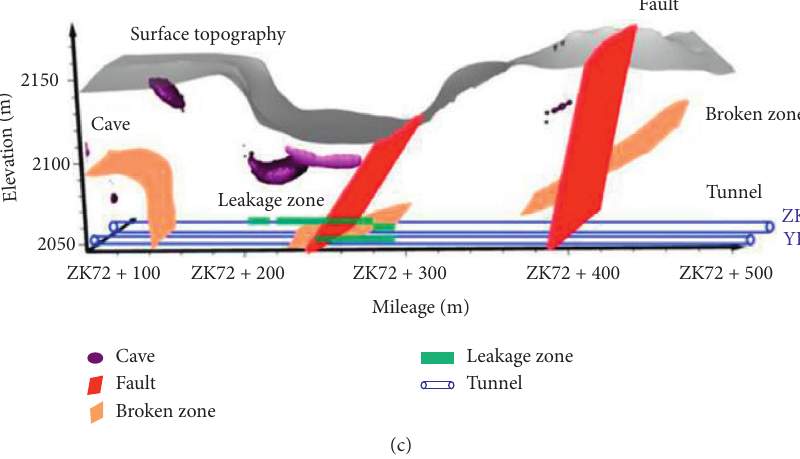
Figure 9: Results of probing and interpreting. (a) Layout map of caverns, fracture zones, and faults; (b) spatial distribution map of caverns, fracture zones, and faults; (c) spatial distribution map of cavities, broken zones, and faults.